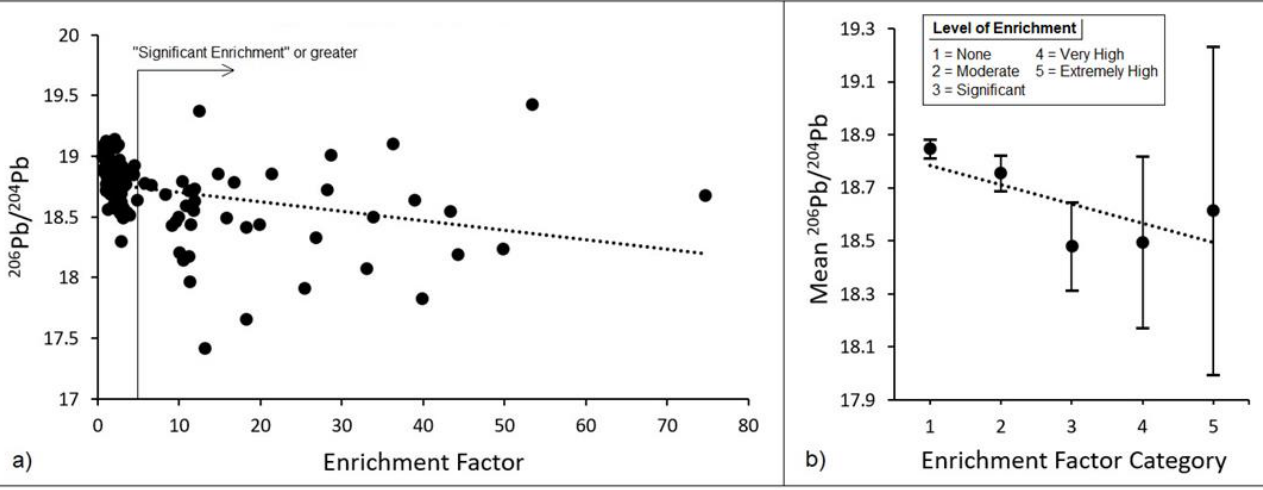
Figure 4. Ratio of ( a ) 206 Pb/ 204 Pb plotted against Pb enrichment factors as measured in the soil, as well as ( b ) average 206 Pb/ 204 Pb (with 95% confidence intervals) plotted against Pb enrichment cate- gories .